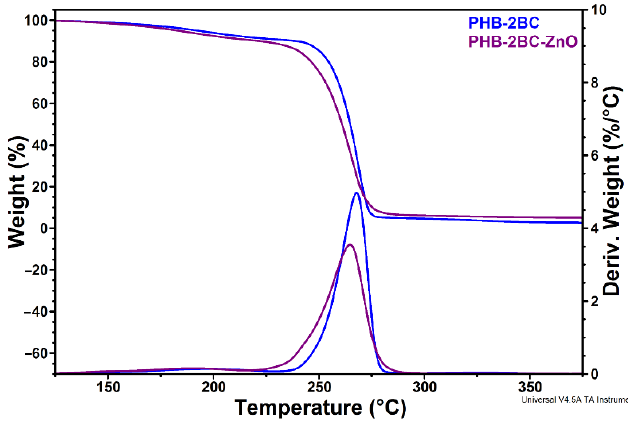
Figure 3. TGA-DTG curves of PHB nanocomposite plasma-coated with ZnO nanoparticles. Table 1. TGA results for PHB nanocomposites before and after the plasma treatment.